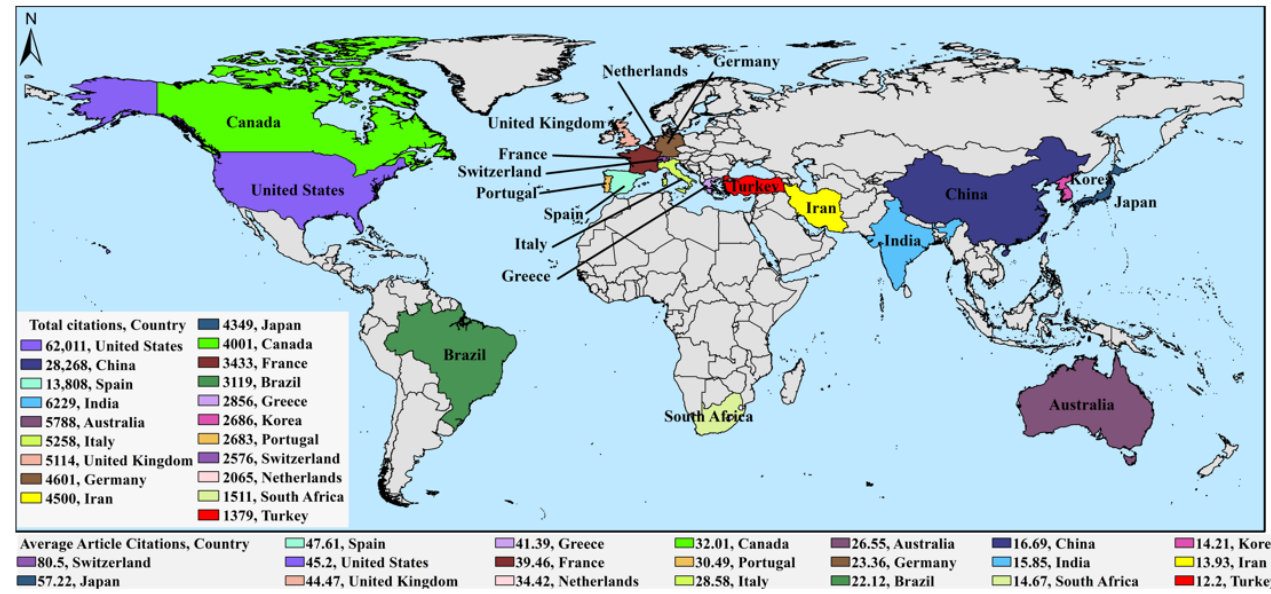
Figure 6. Geographical distribution of the most cited countries based on DI studies. Table 1. Top publications per country based on the corresponding author’s countries in DI stud- ies.